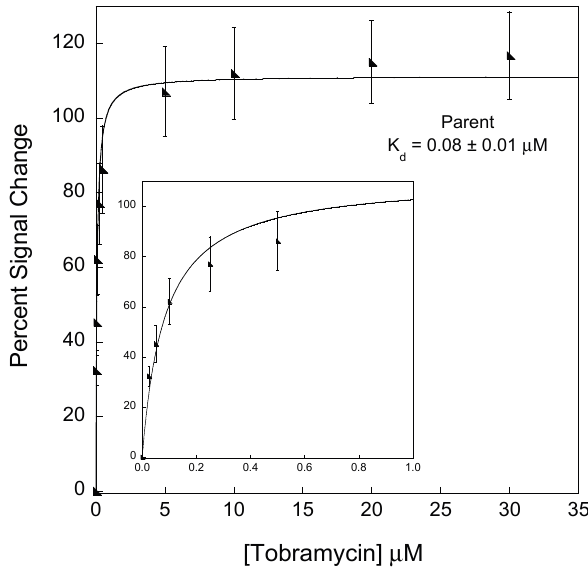
Figure 1. E-AB sensors for tobramycin fabricated with the high-gain parent sequence exhibit a dissociation constant of 0.08 ± 0.01 µM and a 117% ± 12% signal change at saturating levels of tobramycin (>~5 µM). While these sensors are sensitive, they saturate at concentrations much lower than the lowest anticipated concentration in the therapeutic window for the drug (~7–18 µM [33]). The inset illustrates the signal change at concentrations ≤ 1 µM. These data represent titration curves calculated as percentage signal change using voltammetric peak currents as described in the experimental section. Each data point represents the average and standard deviation of at least three independently fabricated